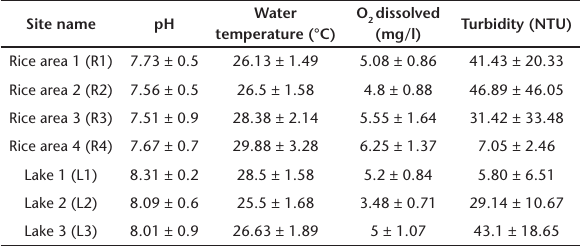
Table 3. Physiochemical variables (mean ± SE) evaluated from different habitats in this study